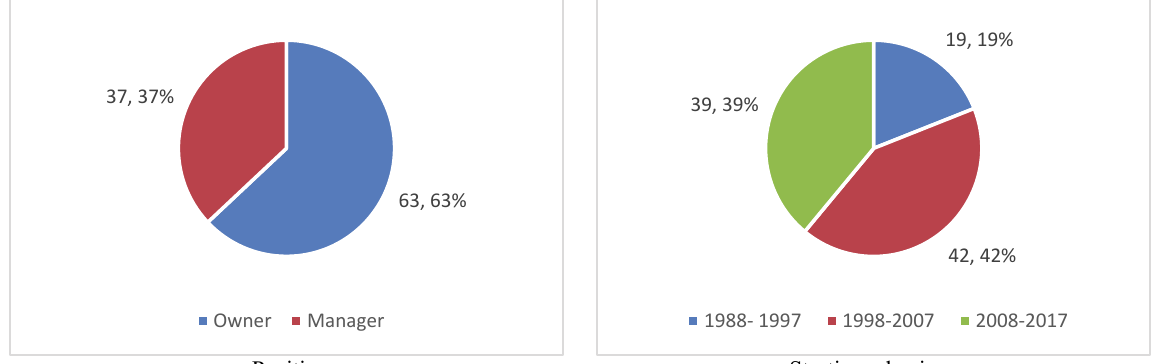
Fig. 2. Characteristics of Respondents